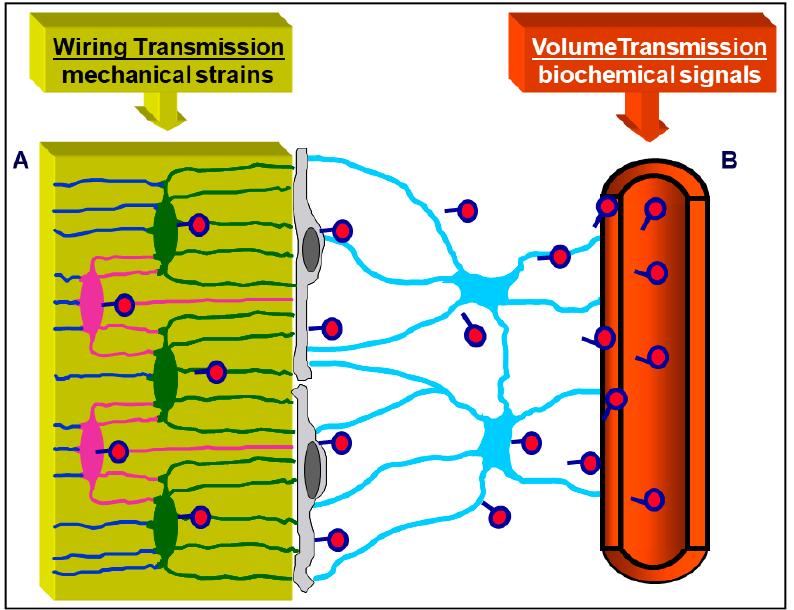
Figure 7. Schematic picture of the BBCS, in which signal transmissions can occur by volume transmission (VT) and/or wiring transmission (WT): ( A ) VT corresponds to the routes followed by soluble substances; ( B ) WT represents the diffusion of ionic currents along cytoplasmic processes. Biochemical signals (hormones diffusing from the blood, cytokines, etc.) first affect stromal cells and diffuse by VT to reach the other cells of BBCS, whereas mechanical agents are firstly sensed by osteocytes and then issued throughout BBCS by WT.